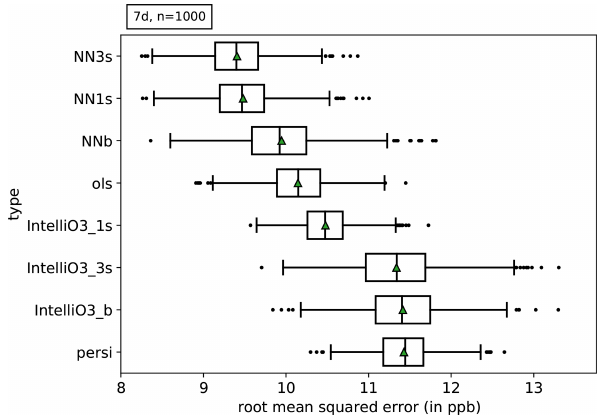
Figure 7. Skill scores of the NN3s model versus the reference mod- els persistence (persi), ordinary least-squares (ols), single upstream sector model (NN1s) and pseudo-station model (NNb) based on the mean squared error, separated for all lead times (1d (dark blue) to 4d (light blue)). Positive values denote that NN3s performs better than the given references. Triangles display the arithmetic